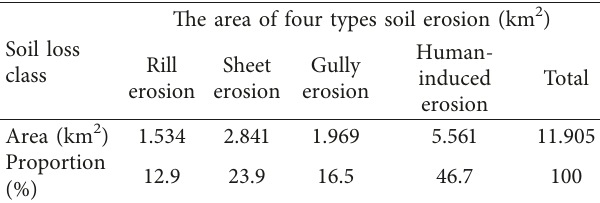
Table 5: Areas of the interpreted four types of soil erosion in NNNR.